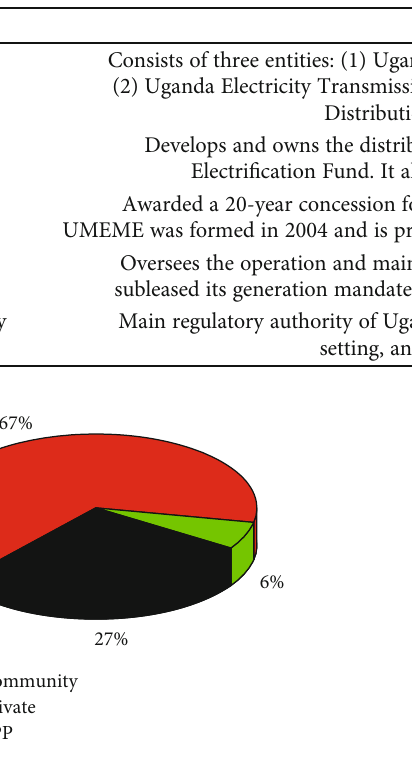
Table 1: Institutions involved in the energy sector in Uganda.